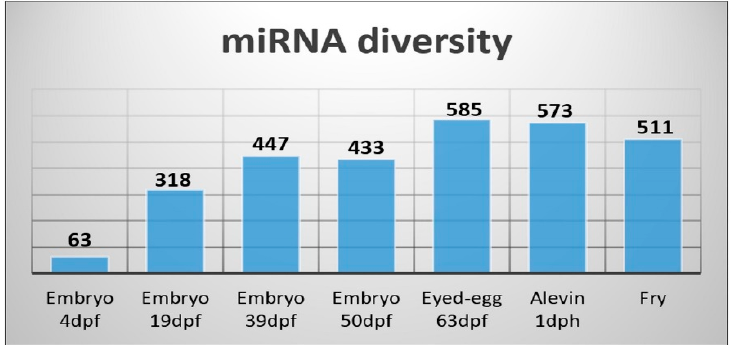
Figure 6. miRNA diversity measured as a number of different miRNAs detected across developmental